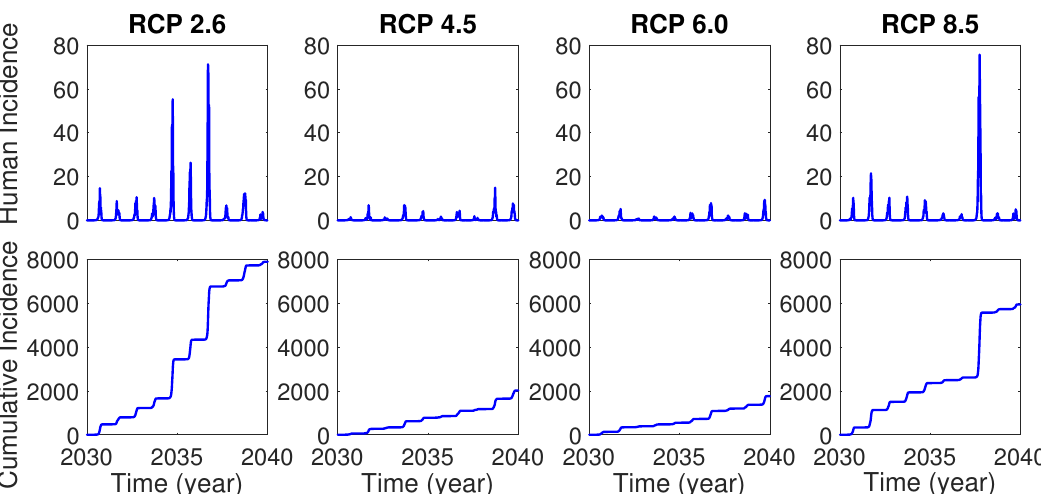
Figure 4. Human incidence ( top ) and cumulative human incidence ( bottom ) for 10 years from 2030 without control.